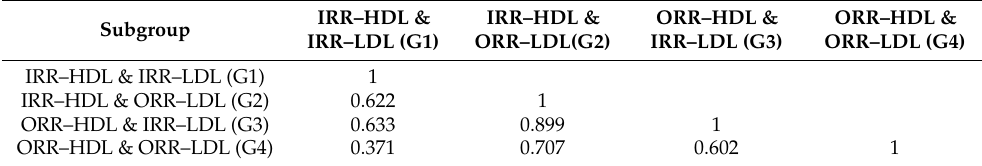
Table 6. Correlation coefficients ( R ) of the variable importance ranking orders of the four